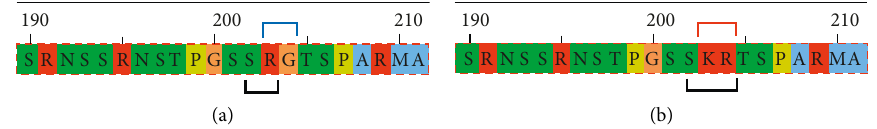
Figure 3: Impacts of 203–204:RG > KR mutation in the N protein. (a) The wild-type N protein with intact S-R dipeptide and (b) the mutated N protein which has the S-R dipeptide disrupted with the insertion of lysine in between them. Blue and red bars on the top indicate the wild type and mutated amino acids, respectively. Bottom black bar in (b) with asterisk indicates the disrupted S-R